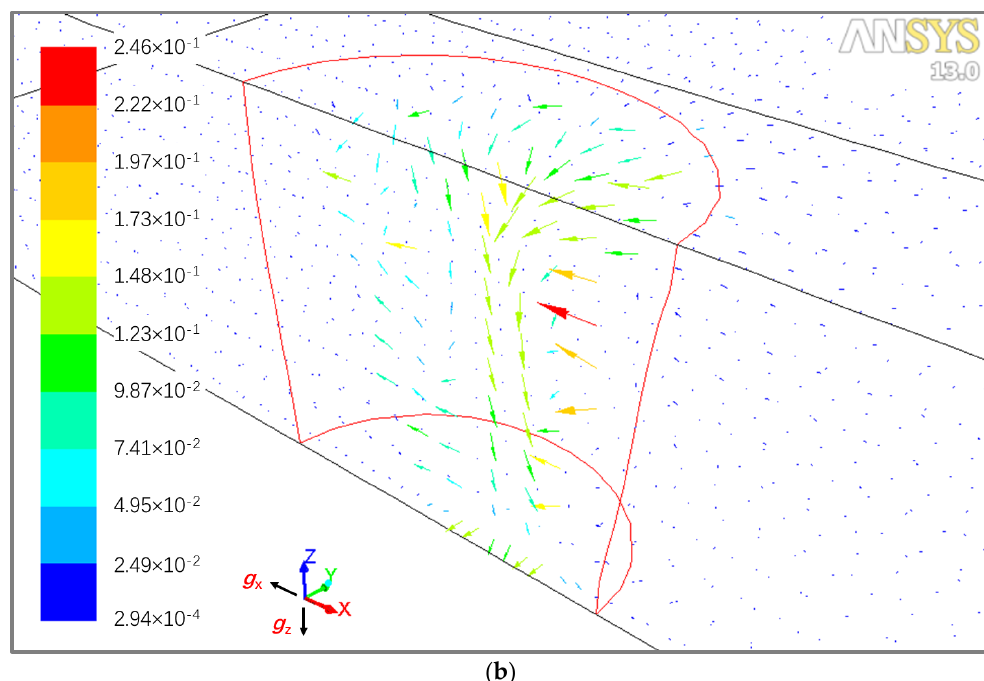
Figure 9. Velocity fields in the weld pool for climbing welding (unit: m/s): ( a ) whole model; and ( b ) magnified melt pool region.